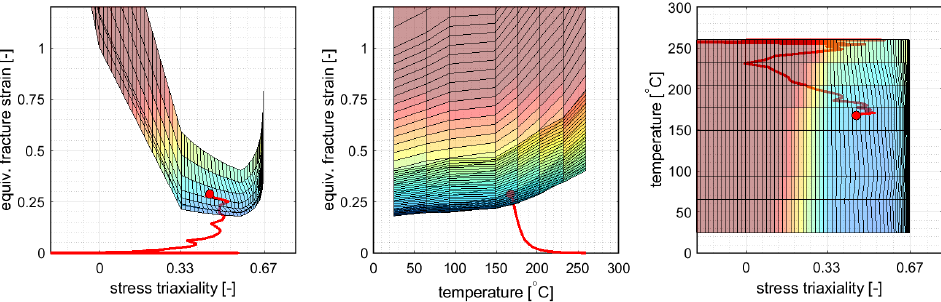
Figure 9. The failure surface at the onset of necking from Figure 8 depicted in different